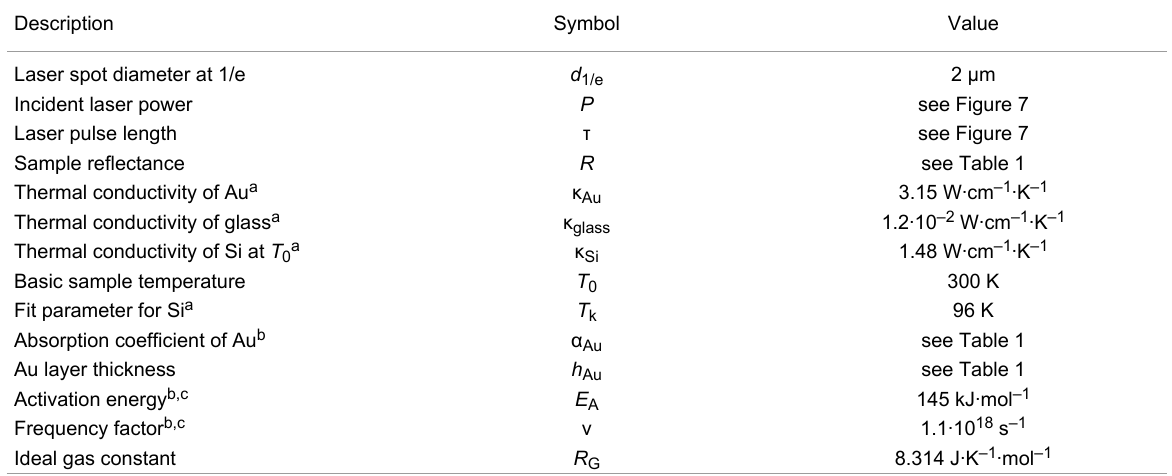
Table 3: Parameters and constants used in temperature calculations and thermokinetic simulations. Description Symbol Value Laser spot diameter at